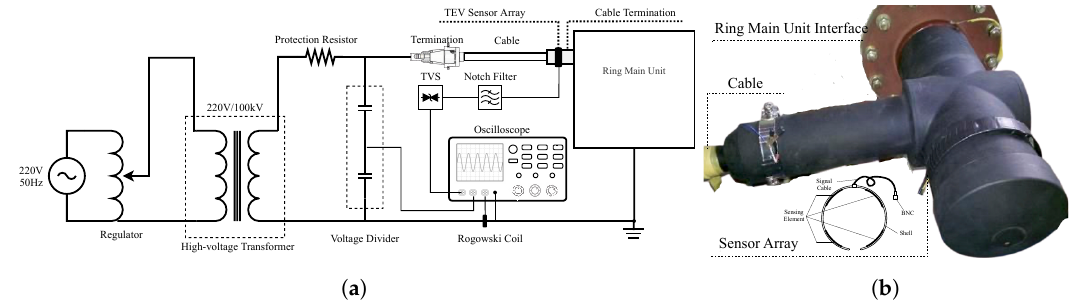
Figure 9. Schematic diagrams of experiment arrangement. ( a ) Schematic representation of the test setup showing the physical arrangement. ( b ) The cable termination and flexible TEV sensor array in a laboratory environment. A 1-centimeter-long metal particle is installed inside the cable termination and about 2 centimeters from the protective cover as an artificial defect.